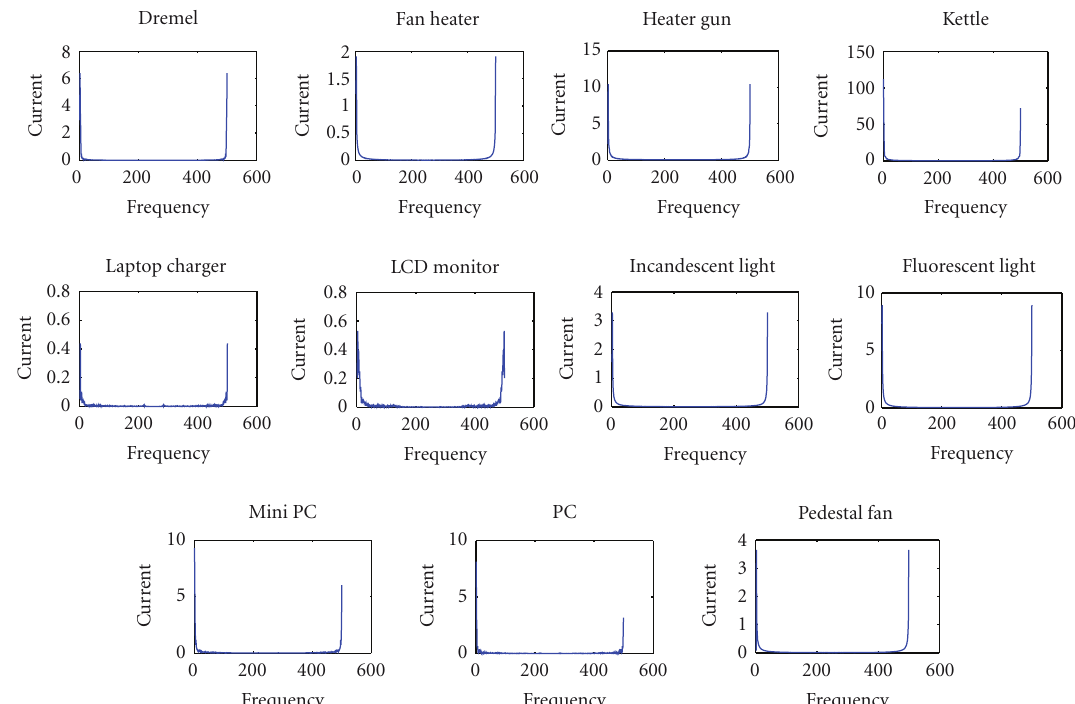
Figure 7: Examples of training set of current data in frequency domain (steady